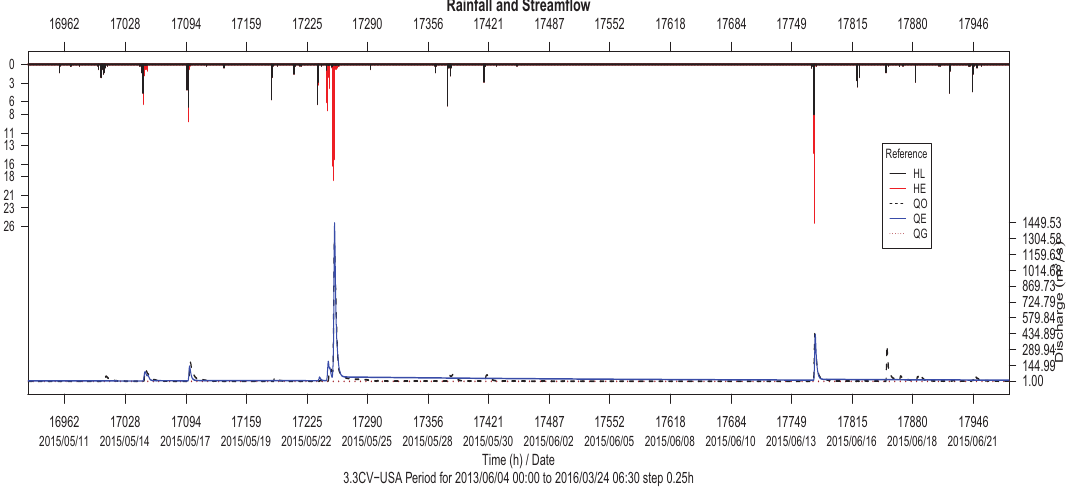
Figure 14. Hyetograph and Hydrograph from validation data series 3.3CV-Zoom of San Antonio river, at Loop 410, USA.